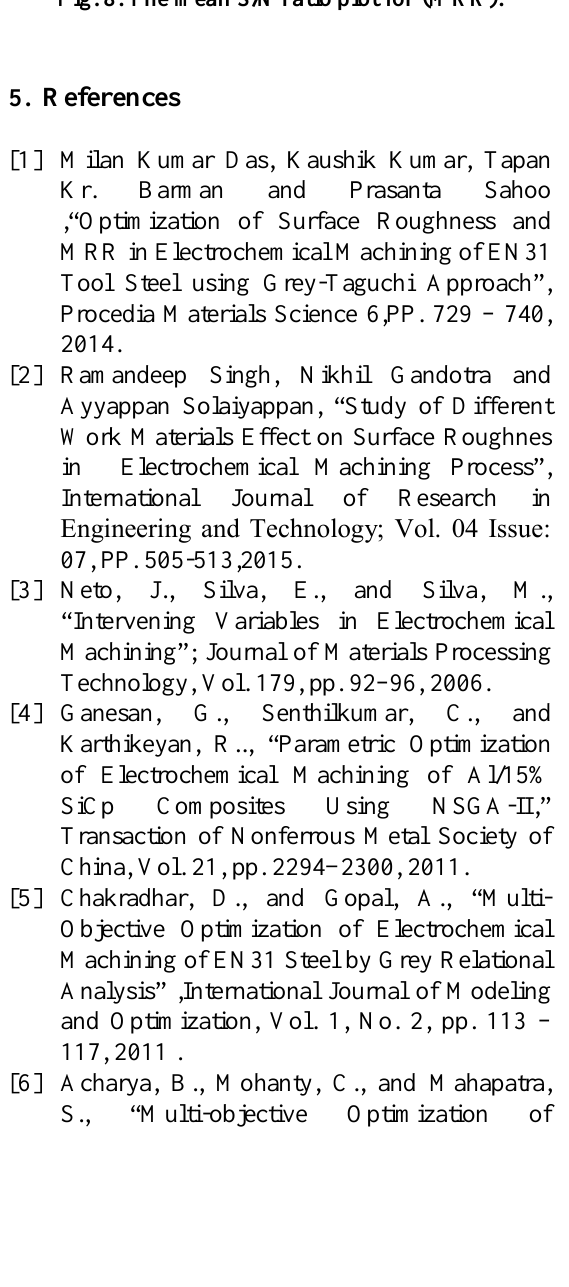
Fig. 7. Main effects Plot for means (MRR). Fig. 8. The mean S/N ratio plot for